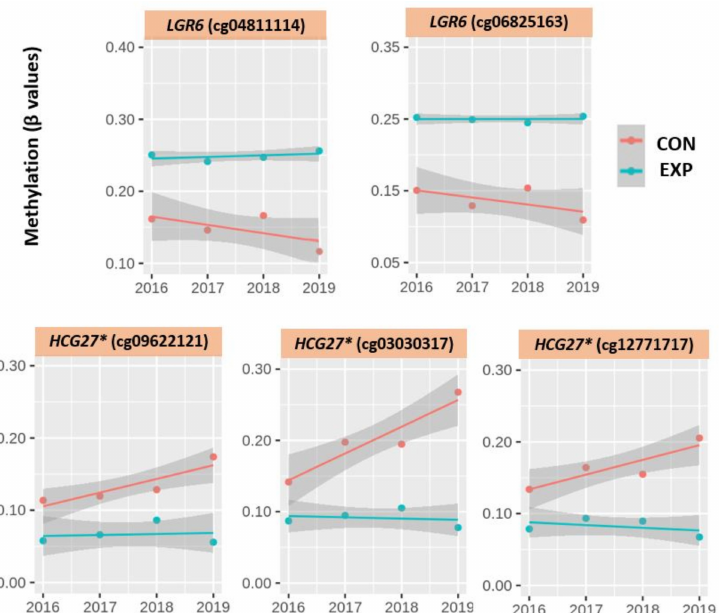
Figure 6. Beta value trajectories of the exposed and control subjects in four consecutive years for 5 CpG loci with significant beta value